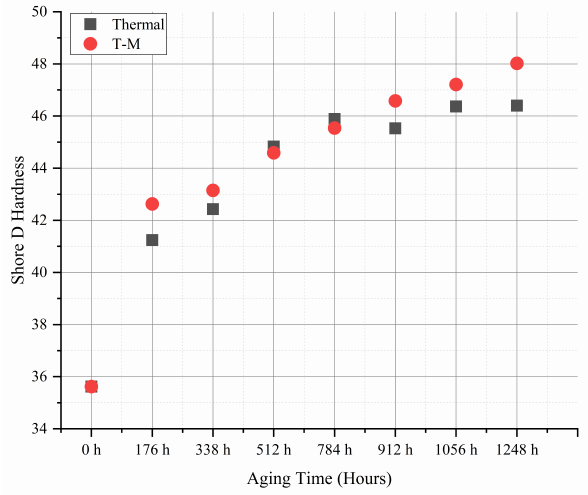
Figure 7. Shore D hardness against aging time thermal and thermo-mechanical (T-M) aging.